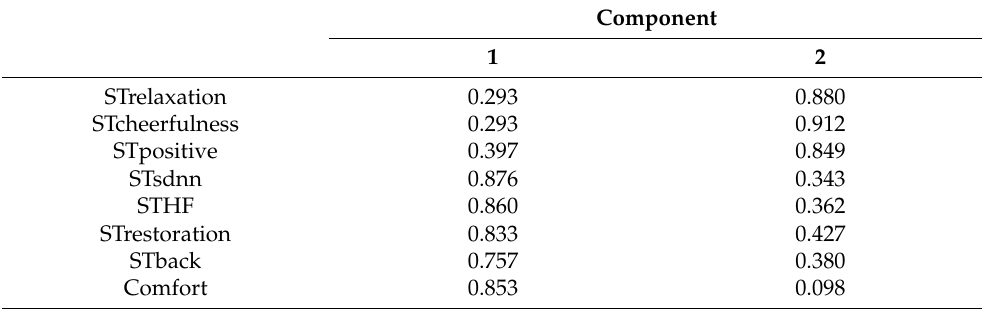
Table 2. Rotated Component Matrix. Figure 3. An AMOS SPSS path model of cognitive vs. emotional indices of coping with Environ- ments.